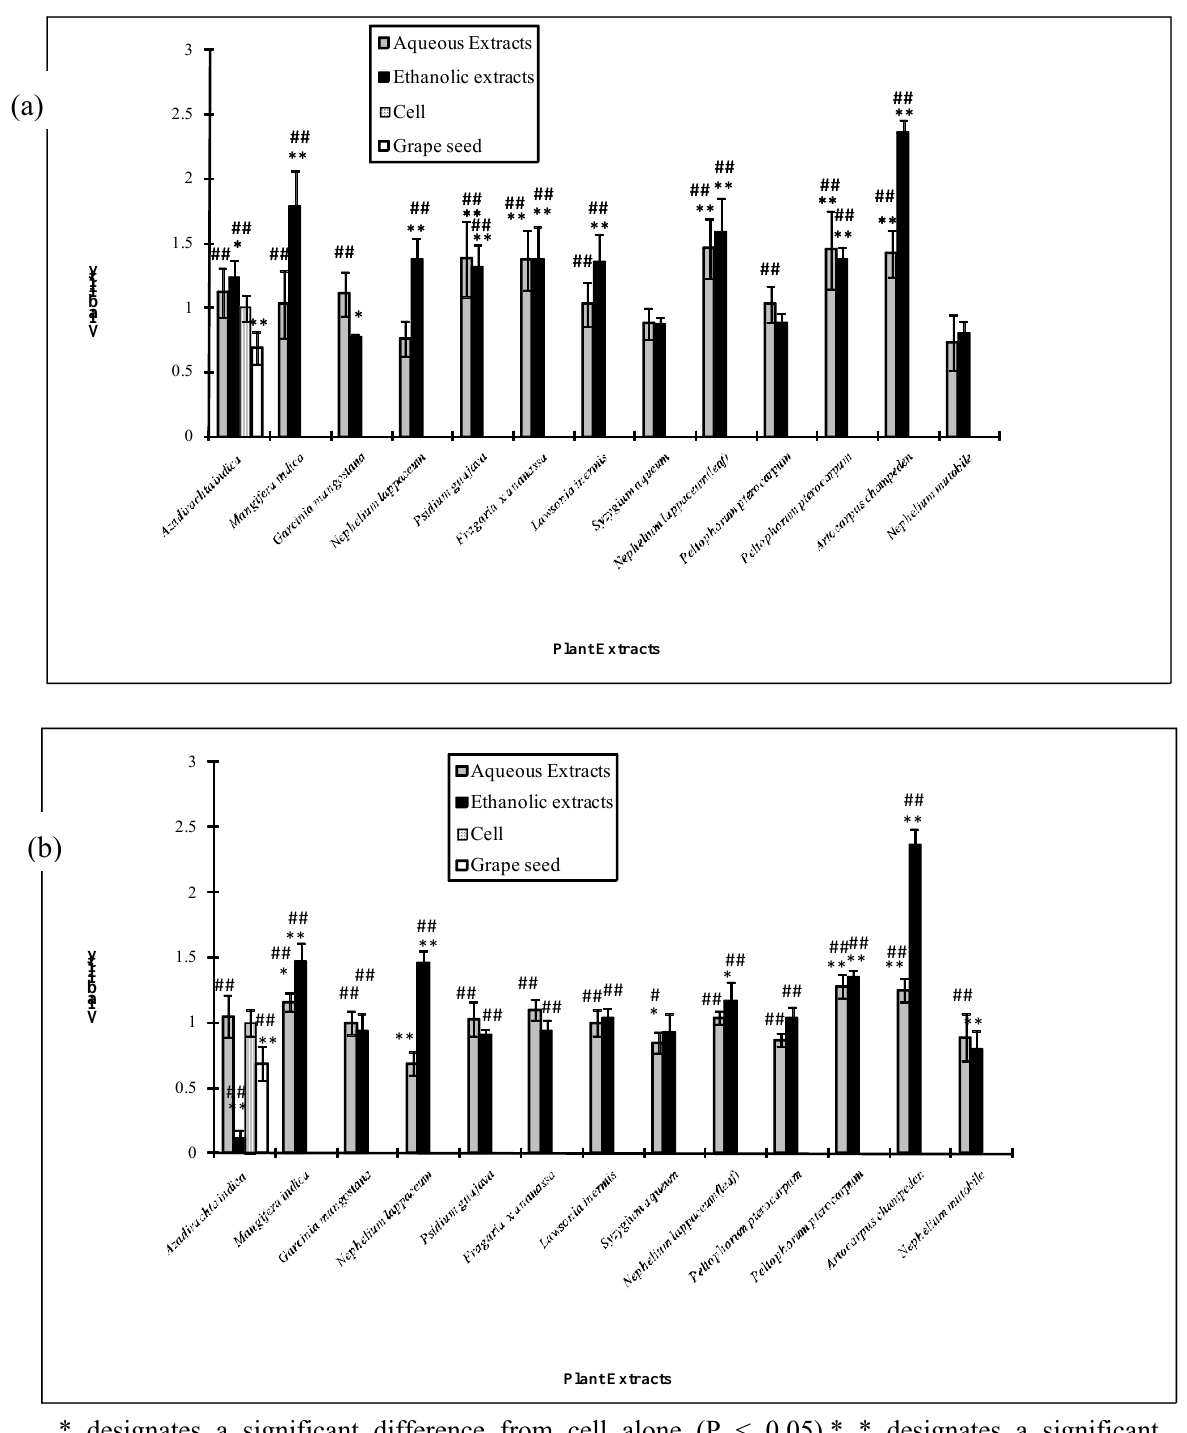
Figure 2. Cytotoxicity activity of selected Malaysian plants on cells at concentration of 100 µg/mL: (a) On 3T3 cells (b) on 4T1